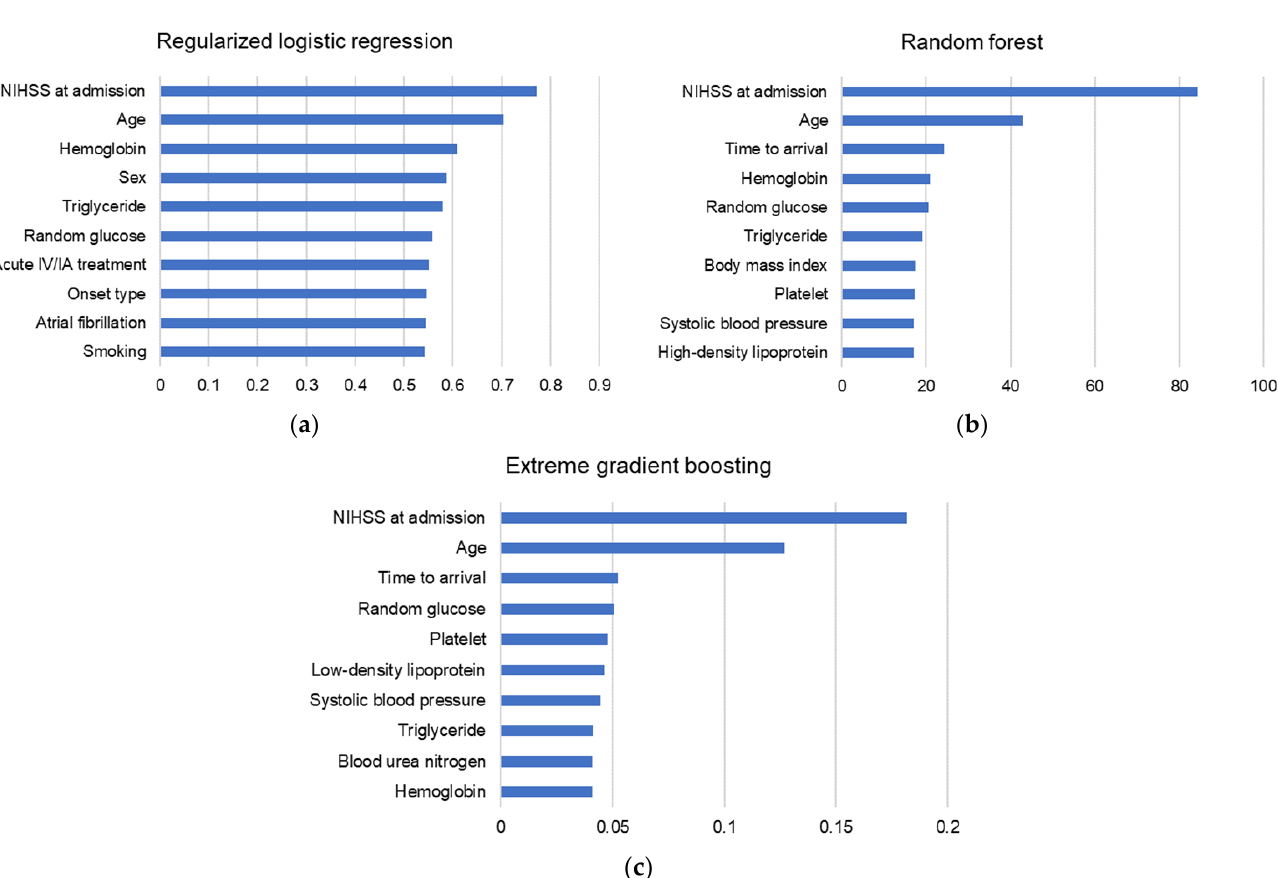
( b ) Figure 3. Results of external validation of each machine learning algorithm. ( a ) Receiver operating characteristic curves and ( b ) calibration plots are represented. The regularized logistic regression model showed the best performance with an AUC of 0.86 (red line). Overall, all the ML models showed AUC > 0.8. AUC, area under the receiver operating characteristic curve; RLR, regularized logistic regression; SVM, support vector machines; RF, random forest; KNN, k-nearest neighbors; XGB, extreme gradient boosting. Among the optimal training models of the best test prediction result for each ML algo- rithm, SVM, XGB, and KNN showed the best performance when target class balancing was not performed. Contrarily, the best-performed model was generated in RLR and RF when SMOTE and ADASYN were applied, respectively. Supplementary Table S2 shows the balanc- ing method and hyperparameter tuning results for the best model of each ML algorithm. 3.4. Variable Importance For RLR, NIHSS was the most important variable for model performance, followed